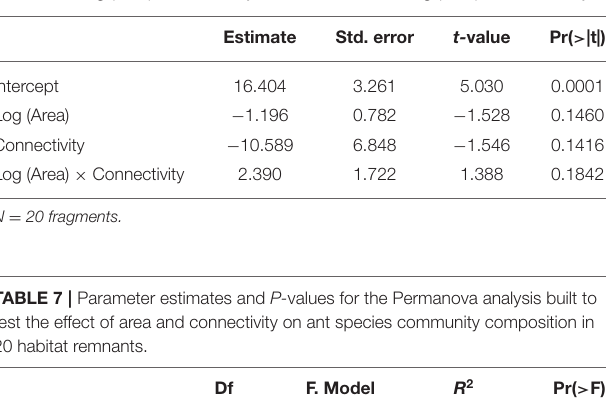
TABLE 6 | Parameter estimates and P- values for the GLM (Gaussian distribution, identity link function) built for species richness rarefied to 44 occurrences as a function of Log (Area), Connectivity and the interaction Log (Area) x Connectivity.